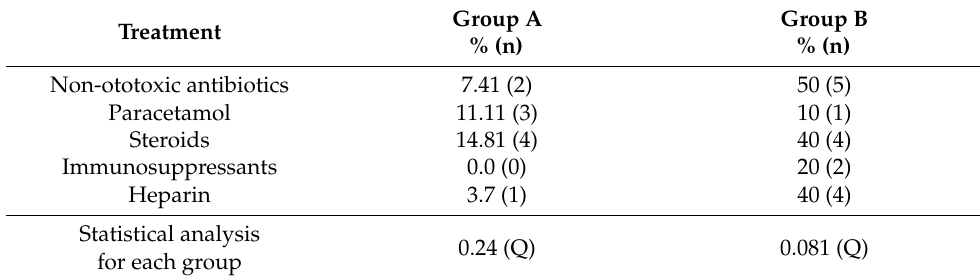
Table 2. Treatments of COVID-19